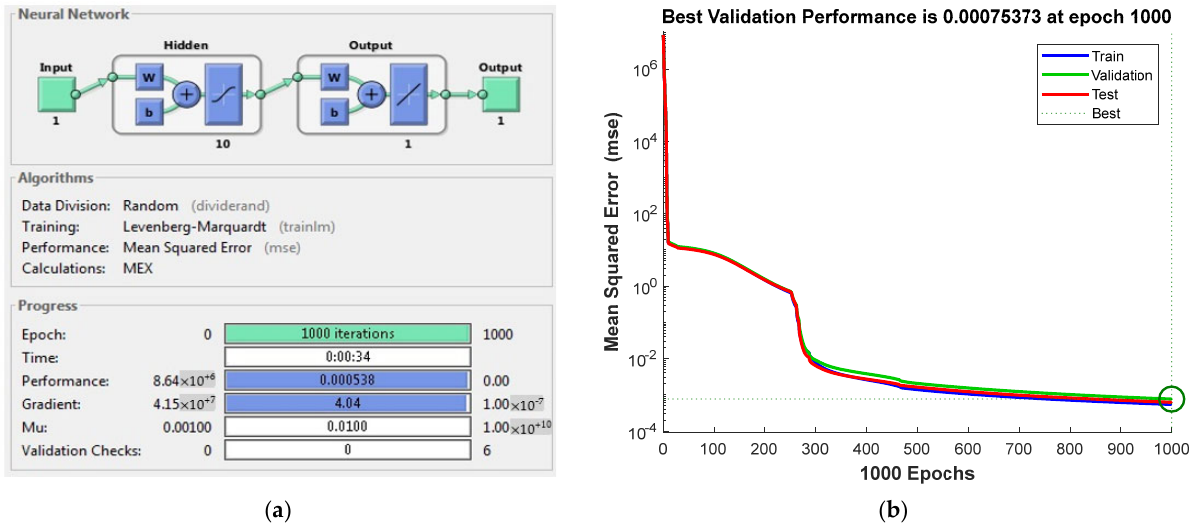
Figure 9. ANN architecture of the speed controller and its evolution formation ( a ). Performance of the mean quadratic error (training, testing, validation) ( b ).